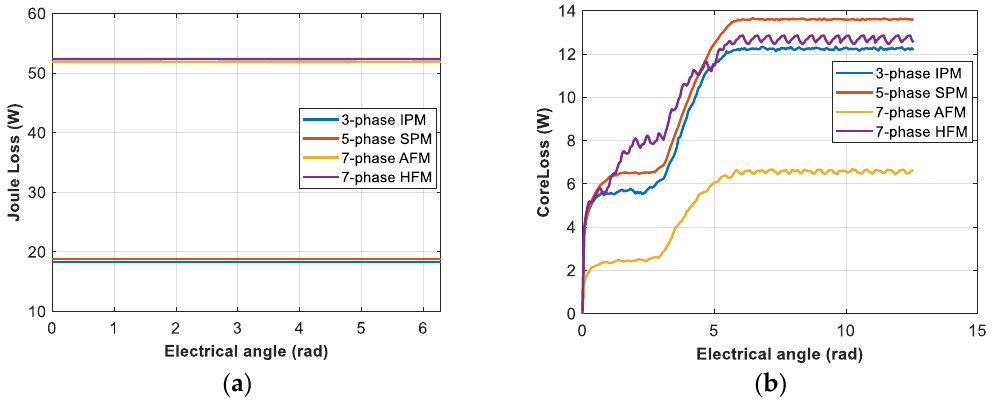
Figure 10. Steady state loss analysis: ( a ) joule losses; ( b ) core losses.